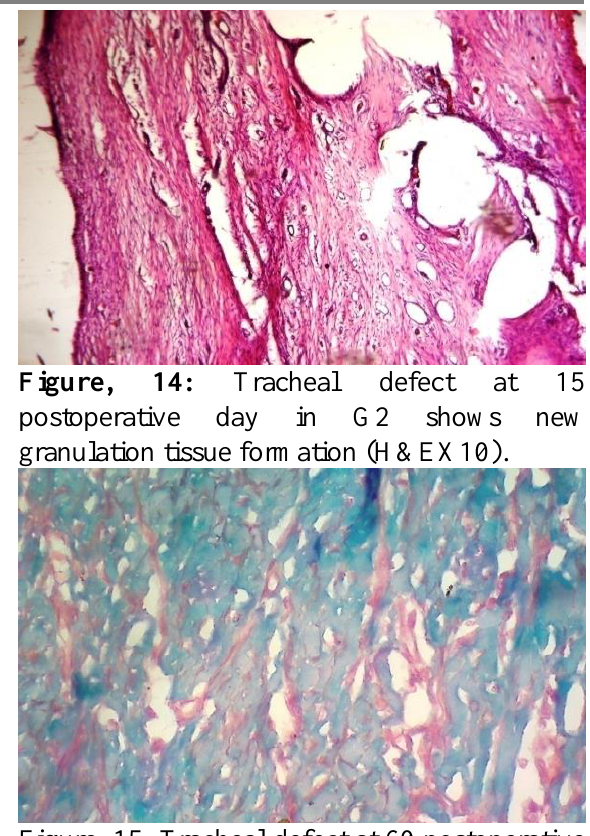
Figure, 15: Tracheal defect at 60 postoperative day in G1with Masson's trichrom shows more maturation for collagen fibers (H&EX10).